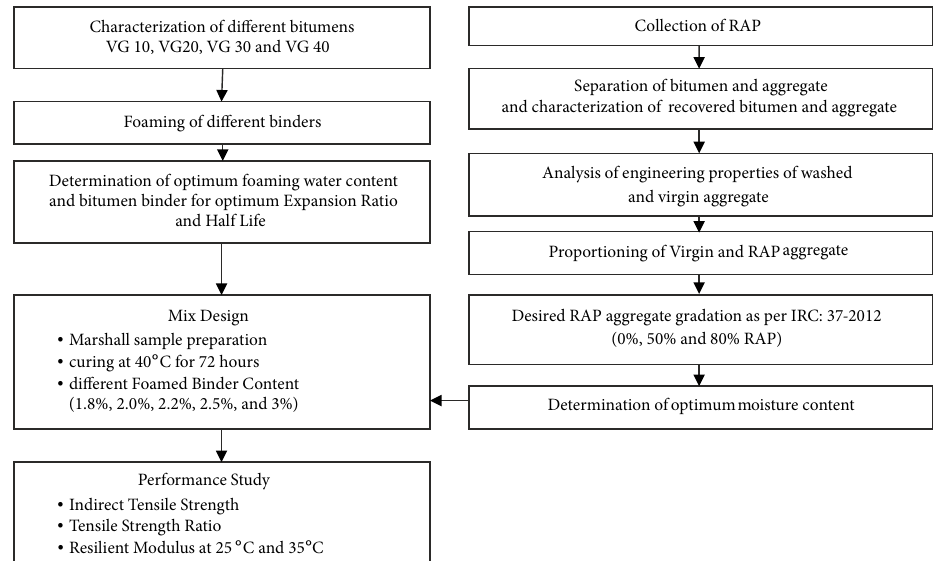
Figure 1. Experimental program